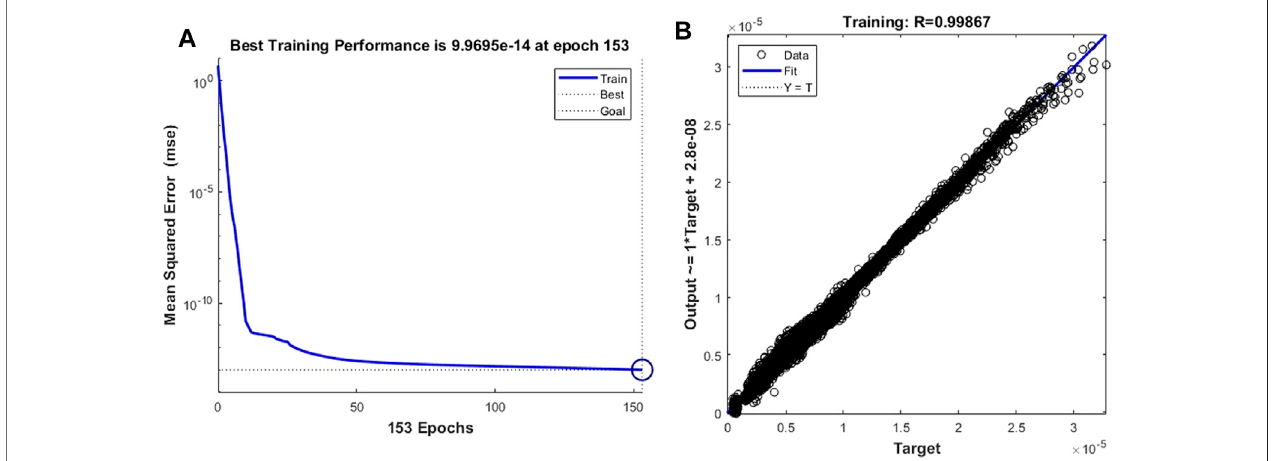
FIGURE 12 | Training performance and fi tting curve of the leukocyte transmigration prediction model used for the prediction of fl uid lift forces on cells (A) Training performance; (B) Fitting curve.